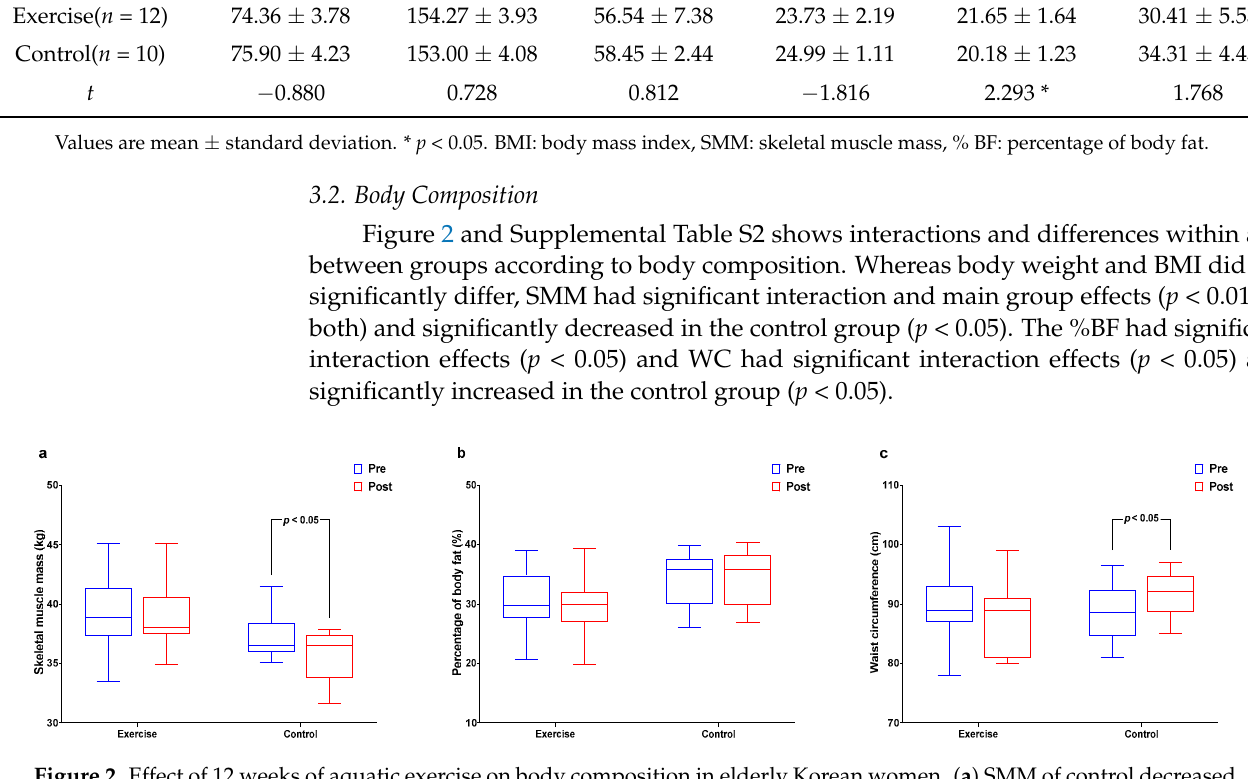
Figure 2. Effect of 12 weeks of aquatic exercise on body composition in elderly Korean women. ( a ) SMM of control decreased significantly ( p < 0.05); ( b ) % BF showed significant interaction effects ( p < 0.05); ( c ) WC of control increased sig-